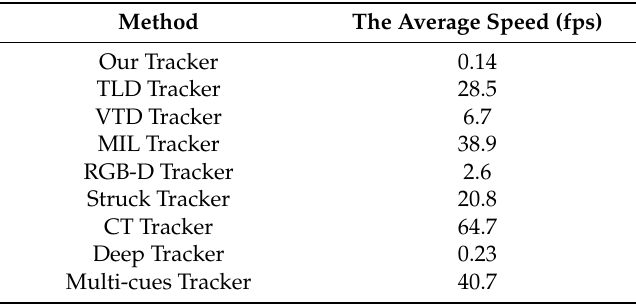
Table 2. The average speed of each method on the recent benchmark dataset